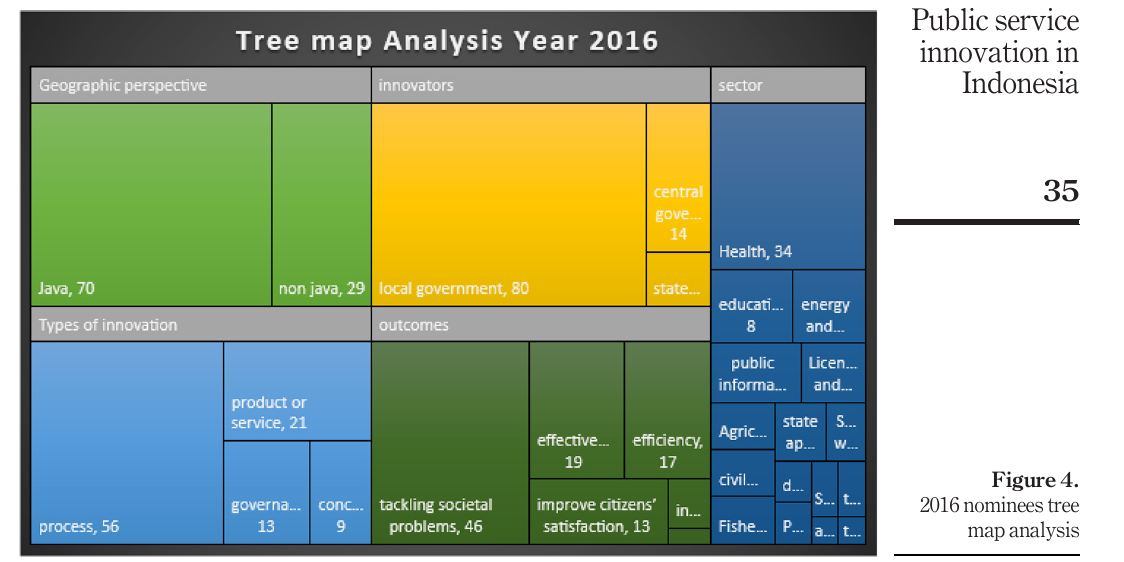
Figure 4. 2016 nominees